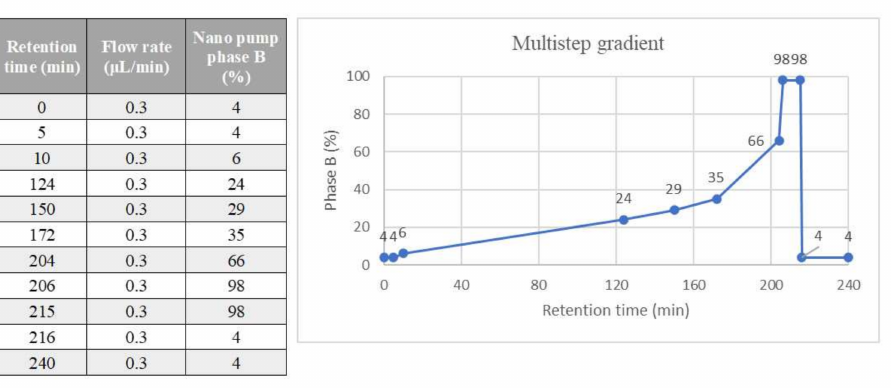
Figure 10. Multistep 240 min gradient for LC separation. The table and the plot show the multistep gradient ranging from 4% to 98% of nanopump phase B used for peptide separation by means of liquid